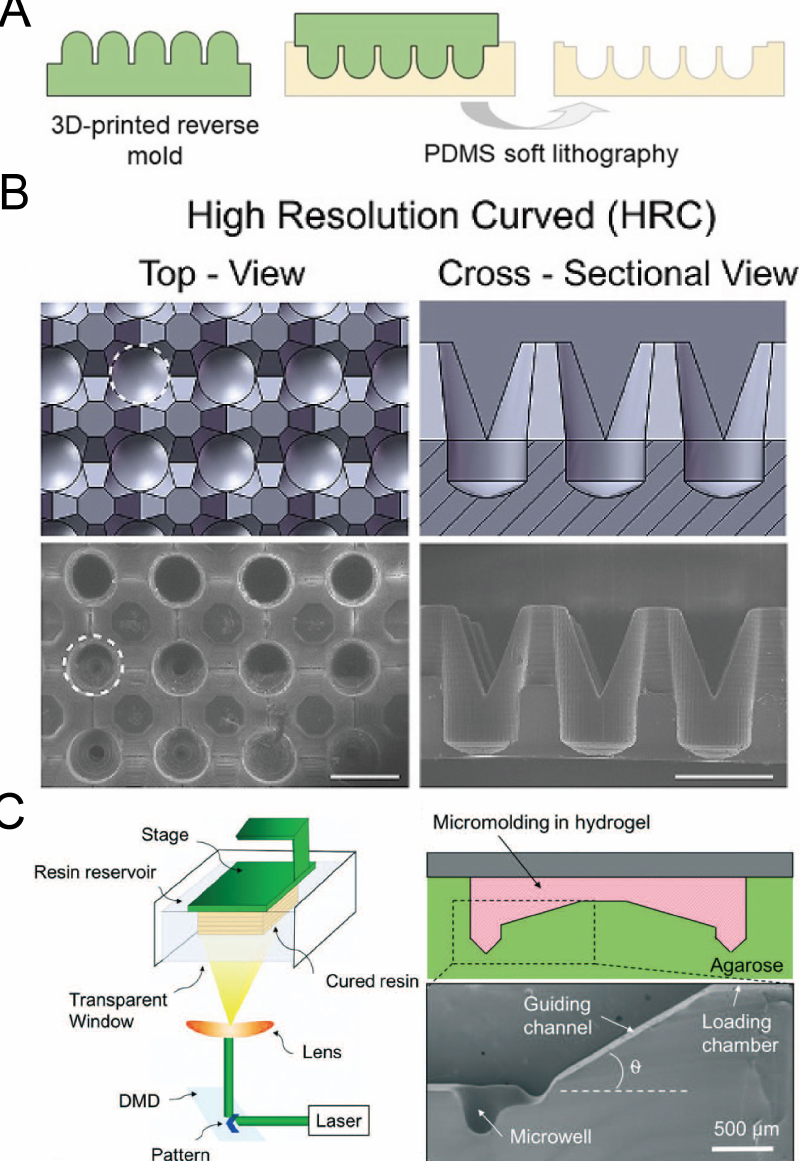
Figure 11. 3D printing for the fabrication of concave microwells. ( A ) At first a rigid mold